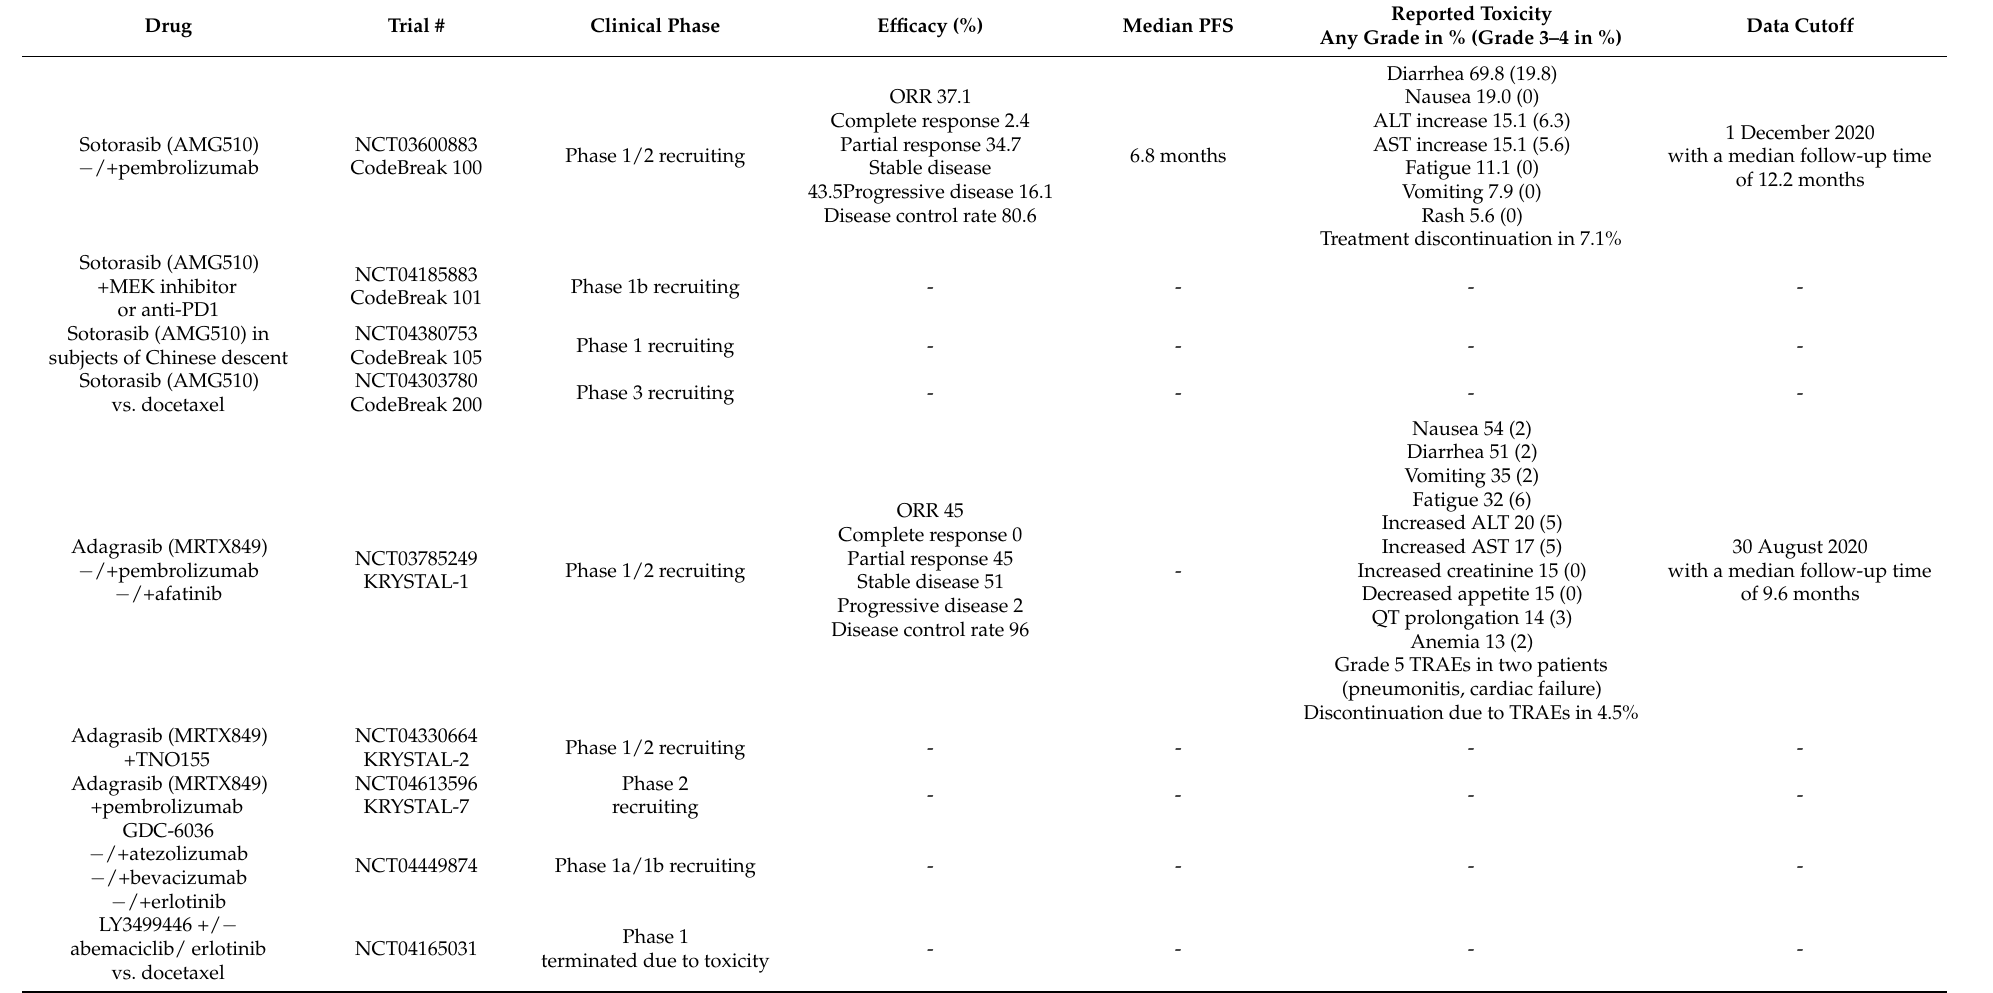
Table 2. Summary of ongoing clinical trials investigating KRAS (G12C) inhibitors alone or in combination with other treatment modalities in NSCLC. ORR = objective response rate, PFS = progression-free survival, TRAE = treatment-related adverse